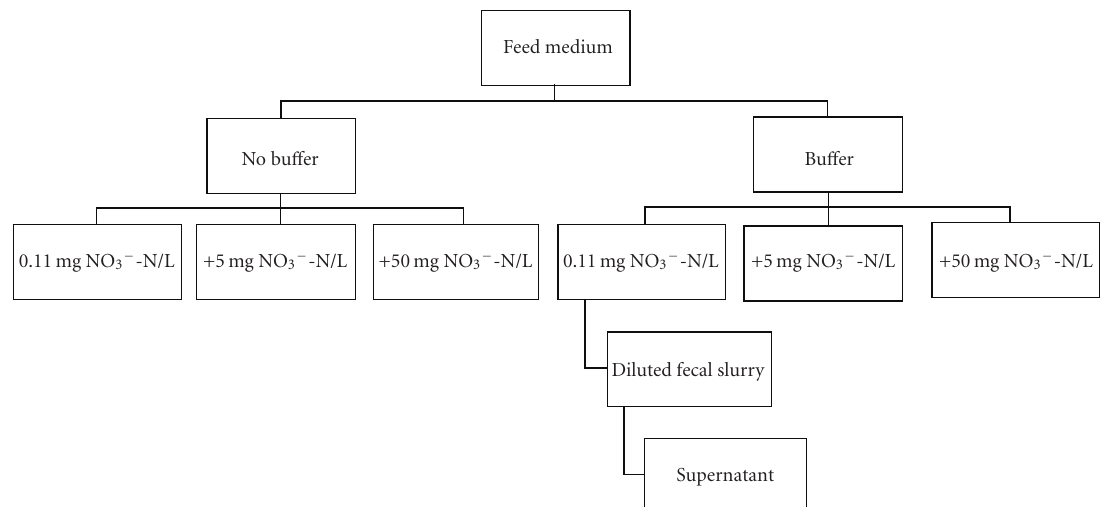
Figure 1: Overview of the experimental setup for the di ff erent parameters that were studied using feed medium simulating the conditions in the human